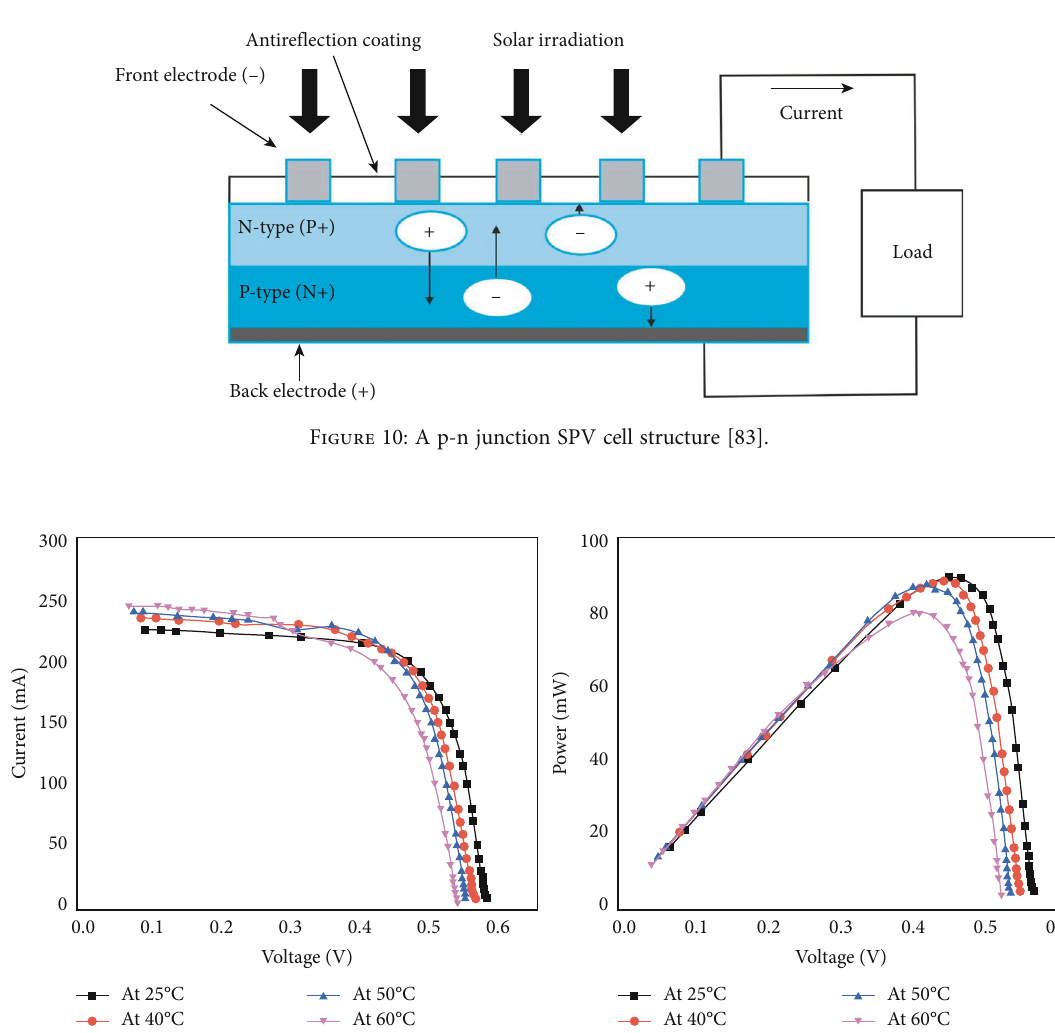
Figure 11: An m-Si SPV cell ’ s current-voltage and power-voltage characteristics are displayed at solar radiation of 515 W/m 2 [84].